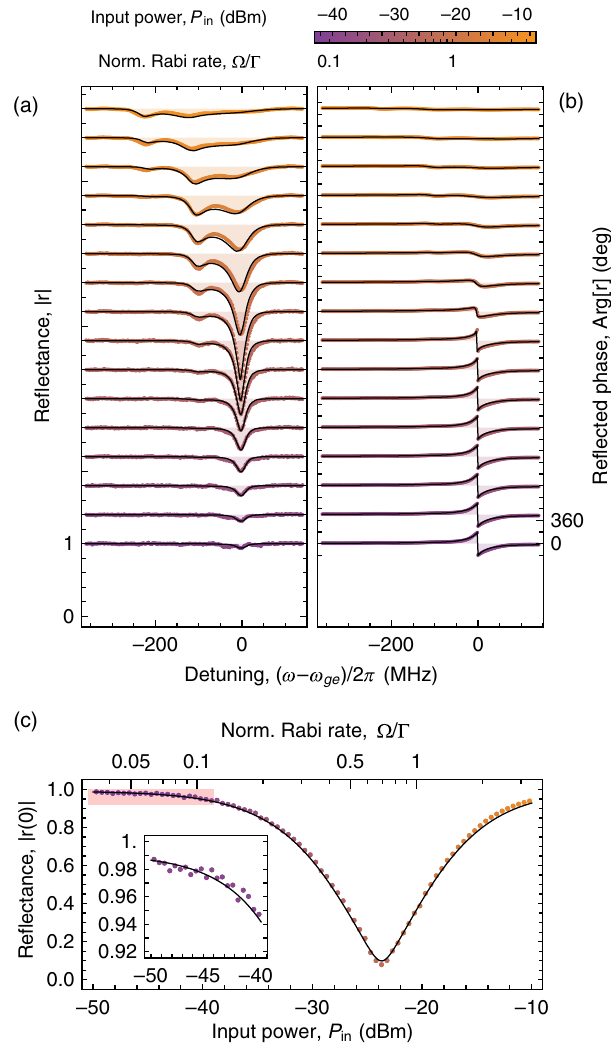
FIG. 2. Single-tone power spectroscopy. (a) Amplitude and (b) phase of the reflection coefficient versus drive detuning at selected input powers P in the range − 39 to − 9 dBm (colored in dots). The traces are vertically offset by 0.4 (450 degrees) for the amplitude (phase). Solid lines show a global fit of a model to all traces (see text for details), from which sample parameters and total line attenuation are extracted. The shaded regions indicate deviations of the reflection coefficients from unit amplitude and zero phase. (c) Reflectance at resonance, j r ð 0 Þj , versus input power: measured values (dots) and theory (solid line). Inset: close-up of the shaded region in the main